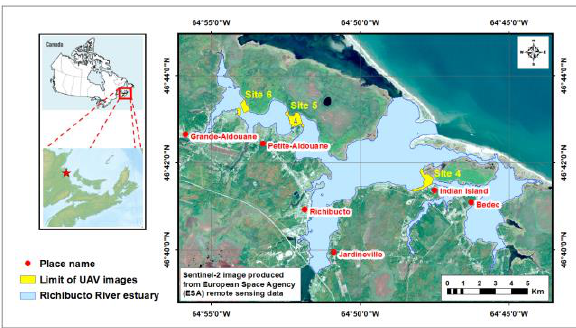
Figure 2. Location and limits of the study area imaged by the UAV over a Sentinel-2 image for the estuary of Richibucto River.